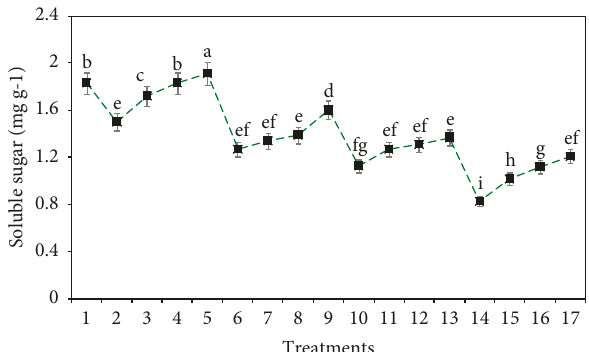
Figure 11: Impact of biosorbed water by various biosorbents (orange peels, pomegranate peels, and peanut peels) on soluble sugar content of mung bean after 7 days of seed germination. T1, negative control; T2, 50mg kg − 1 ; T3, pomegranate peel biosorbed water +50mg kg − 1 ; T4, peanut peel biosorbed water +50mg kg − 1 ; T5, orange peel biosorbed water +50mg kg − 1 ; T6, 100mg kg − 1 ; T7,, pomegranate peel biosorbed